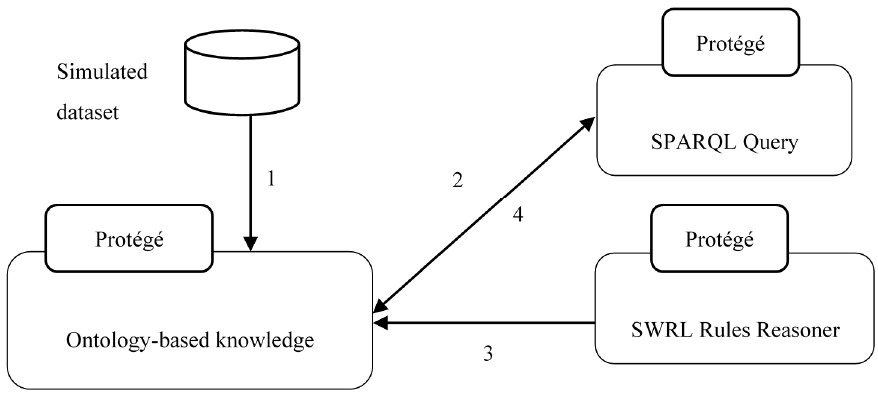
Figure 1. Components of the Protégé platforms [4] .